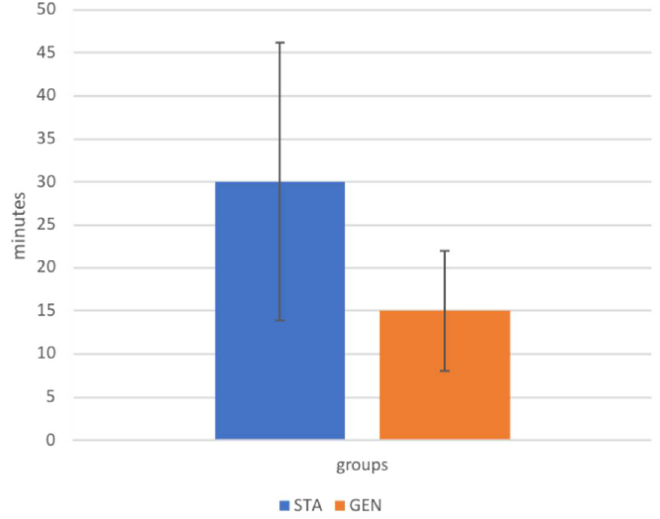
Figure 7. Time elapsed from block execution to start of surgery in horses included in group STA (undergoing standing analgo-sedation, n = 6) and group GEN (undergoing general anesthesia, n = 9). Data are reported as mean ± standard deviation.